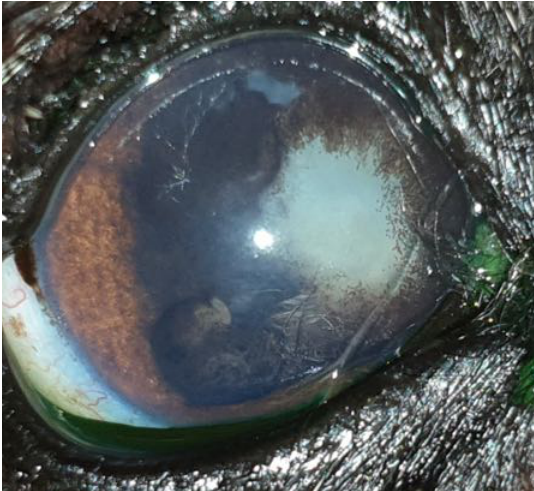
Figure 7. 13yo FN Miniature Schnauzer- chronic lens-induced uveitis and secondary pupil block glaucoma, under treatment- pigment dispersion on the surface of the iris and anterior lens capsule, posterior synechiae, fixed pupil (North Downs